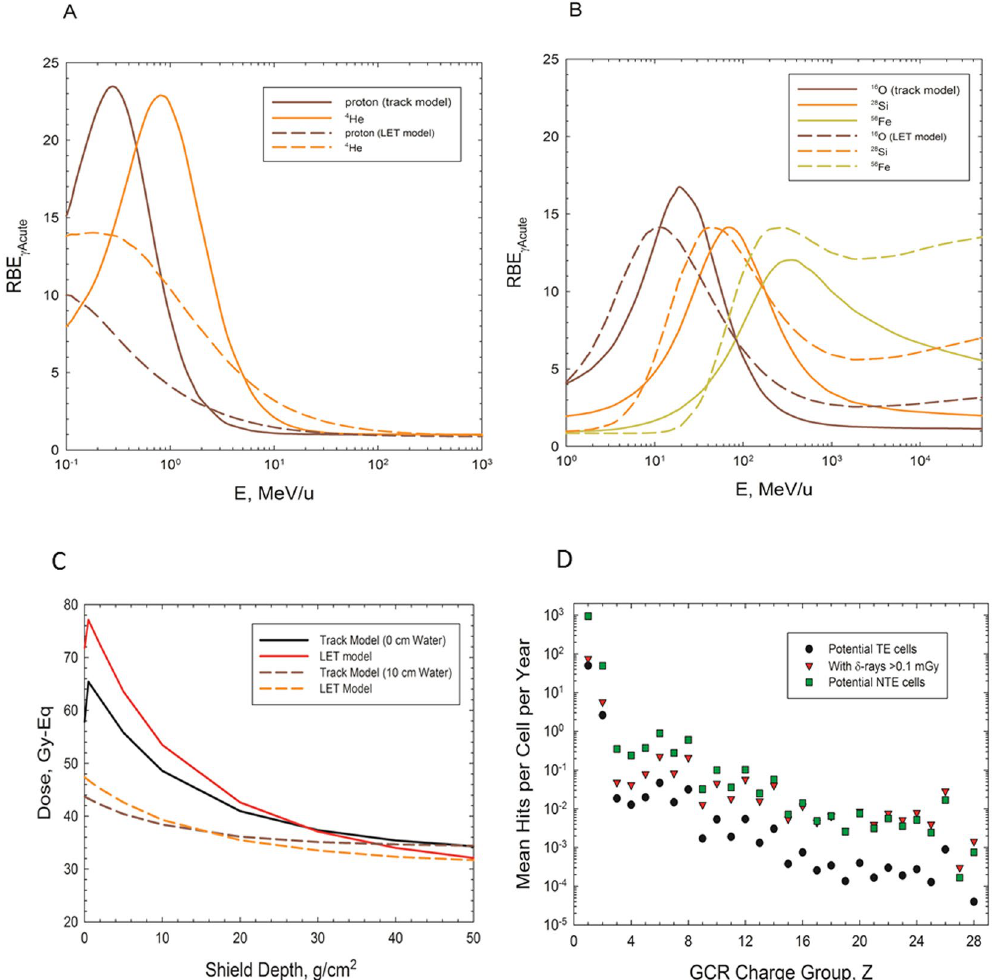
Figure 4. Comparison of relative biological effectiveness (RBE) factors for different particle types versus kinetic energy for the track structure and LET models and the mean number of cells at risk in annual GCR exposures. ( A ) Results for protons and 4 He. ( B ) results for 16 O, 28 Si, and 56 Fe. ( C ) shows a comparison of dose equivalent based on the RBE for Harderian gland tumor prevalence for the track structure and LET dependent targeted effects (TE) models versus aluminum shielding areal density for 0 and 10 cm of tissue depth. ( D ) Predictions of potential number of cells per year susceptible to targeted effects (TE) and non-targeted effects (NTE) for galactic cosmic ray (GCR) exposures at solar minimum assuming 20 g/cm 2 aluminum shielding and 5 cm tissue depth. Also shown are mean number of cells hits per year by δ -rays with an absorbed dose > 0.1 mGy. Calculations use the target area for epithelial cells in the Harderian gland of A cell = 24 μ m 2 with NTE estimates using A bys = 20 A cell as described in the